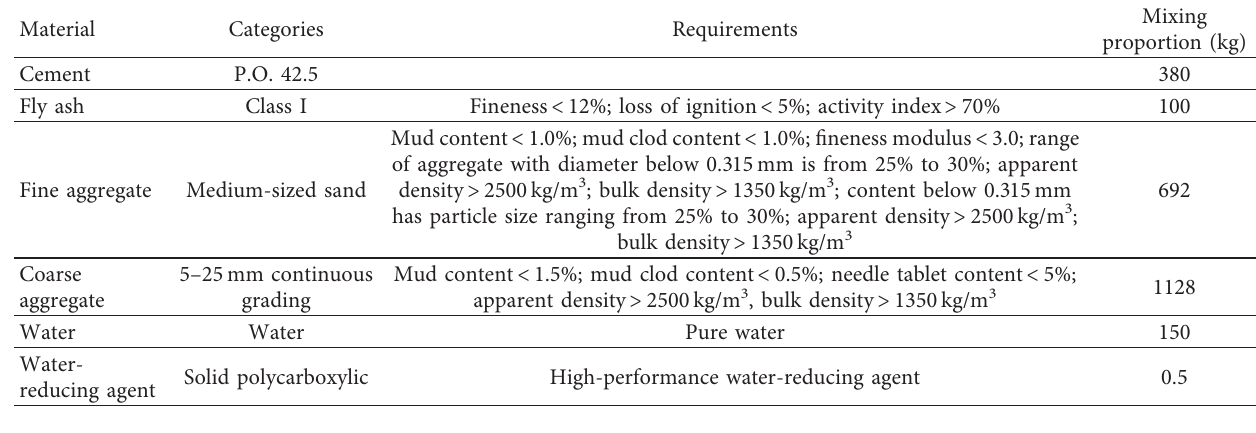
Table 1: Mixing proportions and material category requirements of the tested concrete (C50).